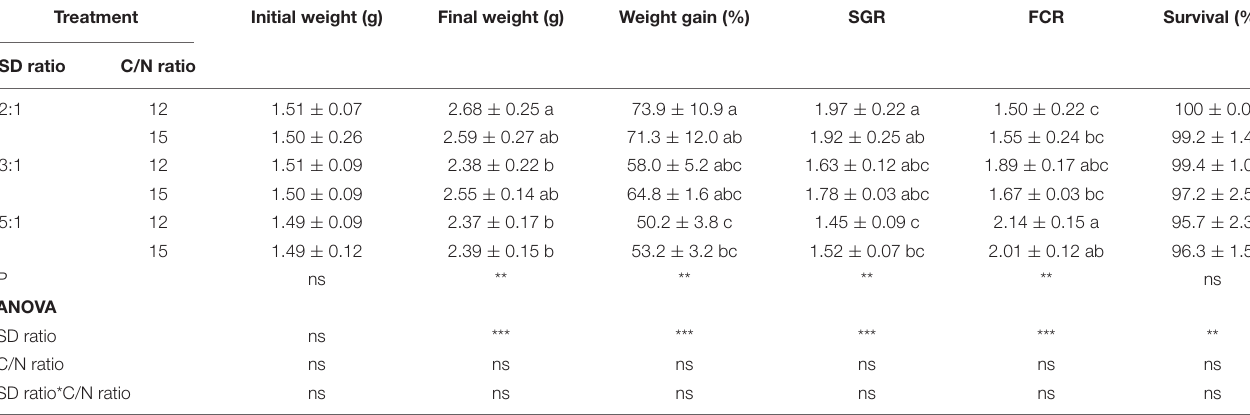
TABLE 1 | Response of shrimp in marine aquaponics at three stocking density ratios (SD ratio) of shrimp to plant and two C/N ratios for 4 weeks.